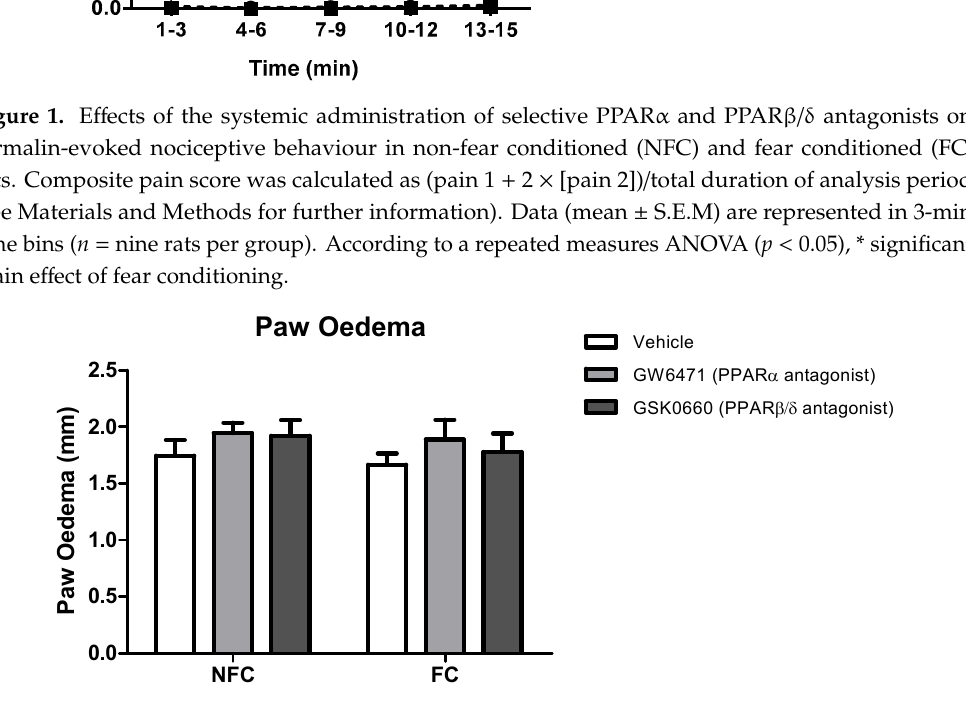
Figure 2. Effects of the systemic administration of selective PPAR α and PPAR β / δ antagonists on formalin-evoked hind paw oedema in non-fear conditioned (NFC) and fear conditioned (FC) rats. Paw oedema was assessed by measuring the change in the diameter of the right hind paw immediately before, and 45 min after, formalin administration. Data are expressed as mean ± S.E.M, n = nine rats per group.